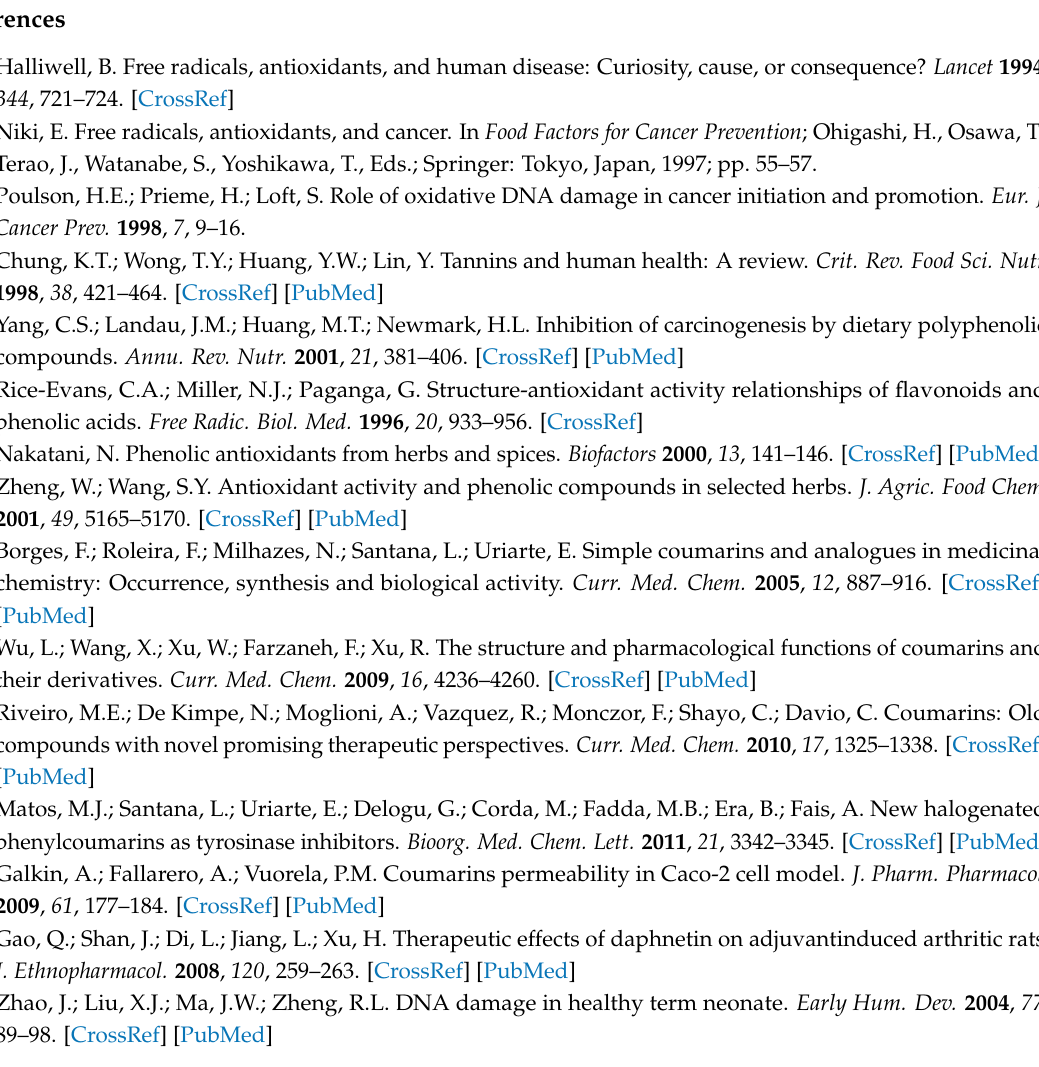
Supplementary Materials: The following are available online, Figure S1: Plot of incubation time vs. natural log percent